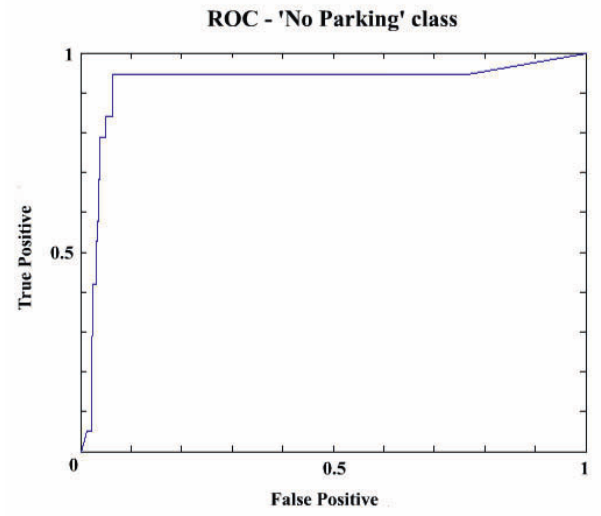
Figure 12. ROC diagram of the NormalBoost classifier for the No Parking